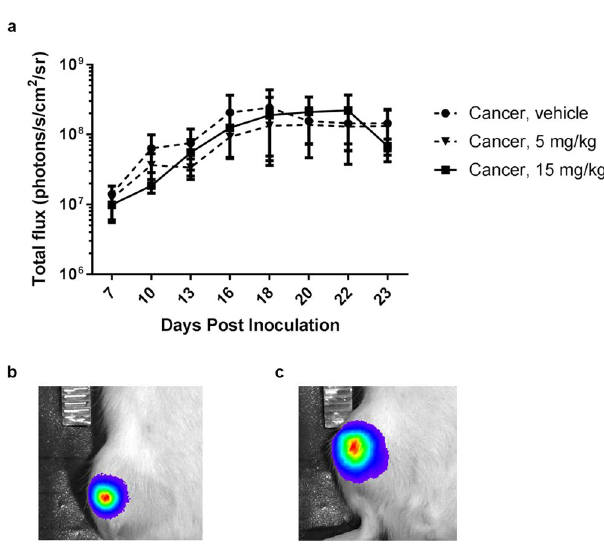
Figure 7. Bioluminescence signal from cancer cells in vivo . ( a ) The signal increases in all groups during the first 16 days until it reaches a plateau. Two-way repeated-measurement ANOVA followed by Bonferroni’s multiple comparison test did not reveal any statistically significant differences between the treatment groups when compared to vehicle on any of the test days (p < 0.05). Data are displayed as mean ± SEM, n = 10–11. Bioluminescent overlay on bright field images ( b ) example of low bioluminescent signal 7 days post inoculation and ( c ) example of high bioluminescent signal 19 days post